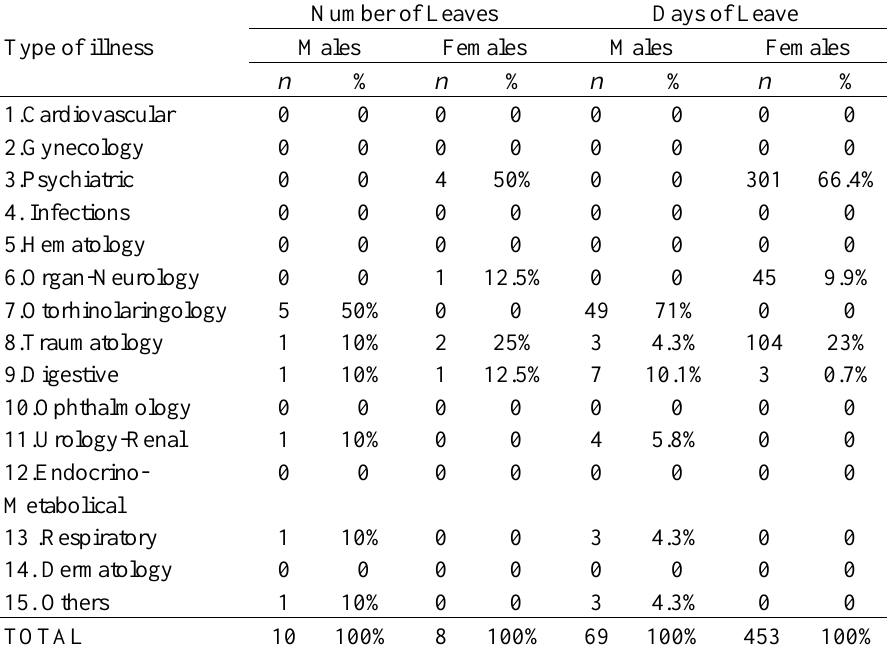
Number of leaves and days of leaves for different types of illness in men and women